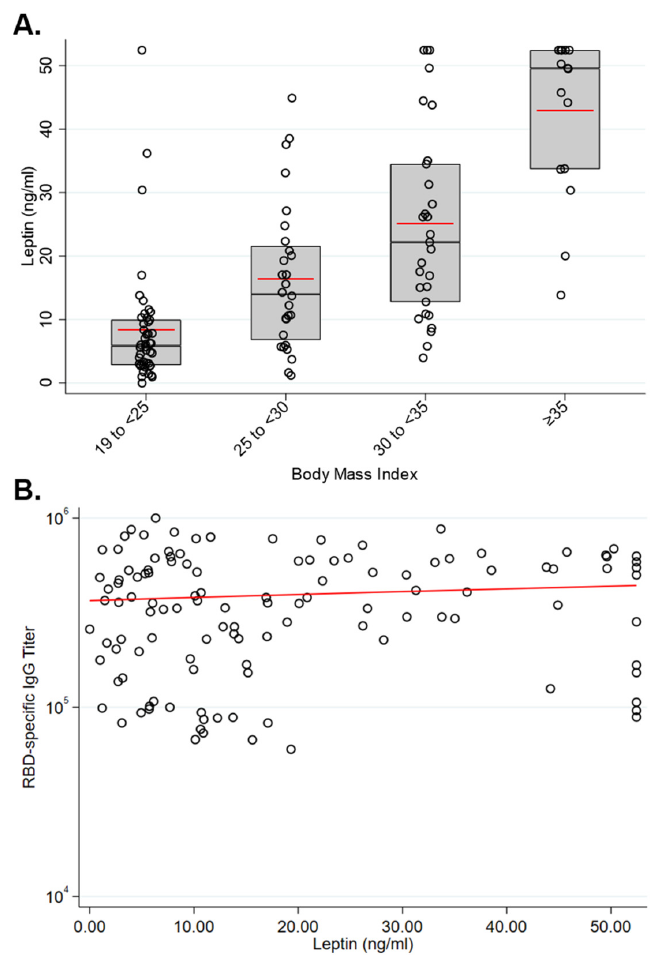
Figure 3. Serum leptin levels 50 days following vaccination. ( A ) Leptin levels significantly increased across BMI groups ( p < 0.001). ( B ) Leptin levels were not significantly correlated with RBD-specific serum IgG levels 50 days following immunization (correlation = 0.10, p = 0.278).